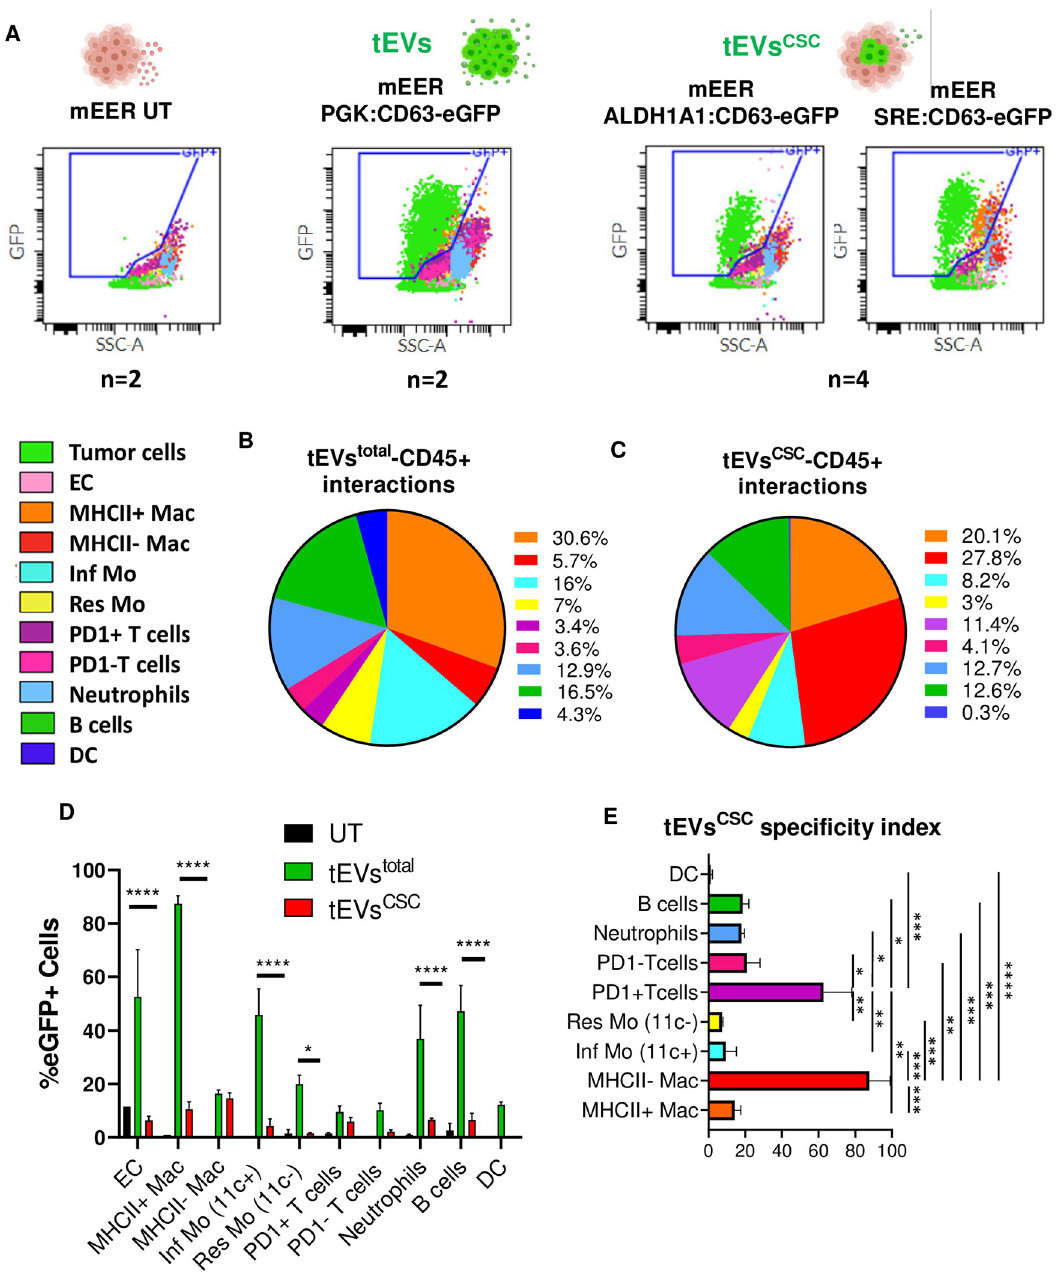
Fig 2. In vivo released mEER tEVs CSC target MHC-II- Mac and PD-1+ T cells in the TME. (A) Representative overlaid plot of color-coded cell subsets present in tumors recovered from mice bearing genetically modified mEER cells studied by flow cytometry. Three different experimental tumor groups were analyzed: tumors formed by i) unmodified mEER cells ii) mEER cells modified with PGK : CD63-eGFP construct (labeling tEVs) and iii) mEER cells engineered with ALDH1A1 : CD63-eGFP and SRE : CD63-eGFP LVs (labeling tEVs CSC ). Sample number (n) for each group is indicated below each plot. CD63-eGFP+ gate is indicated in each case. (B) Representative graph of the % of specific tEVs–CD45+ immune cell subsets interactions from all eGFP+ events in tumors CD45 + cells, showing a major interaction between tEVs and MHC-II+ Mac. (C) Representative graph of the % of specific tEVs CSC –CD45 + immune cell subsets interactions from all eGFP+ events in tumors CD45+ cells, showing a major interaction between tEVs and MHC-II- Mac. (D) Summary graph showing the % of cell subsets presenting CD63-eGFP+ fluorescence in unlabeled EVs tumors (UT), tEV-labeled tumors and tEV CSC -labeled tumors. (E) tEV CSC specificity index showing the preferential interaction of secreted tEVs CSC with specific immune cell subsets. Two-way ANOVA Tukey´s and Holm-Sidak’s multiple comparisons tests were used for statistical